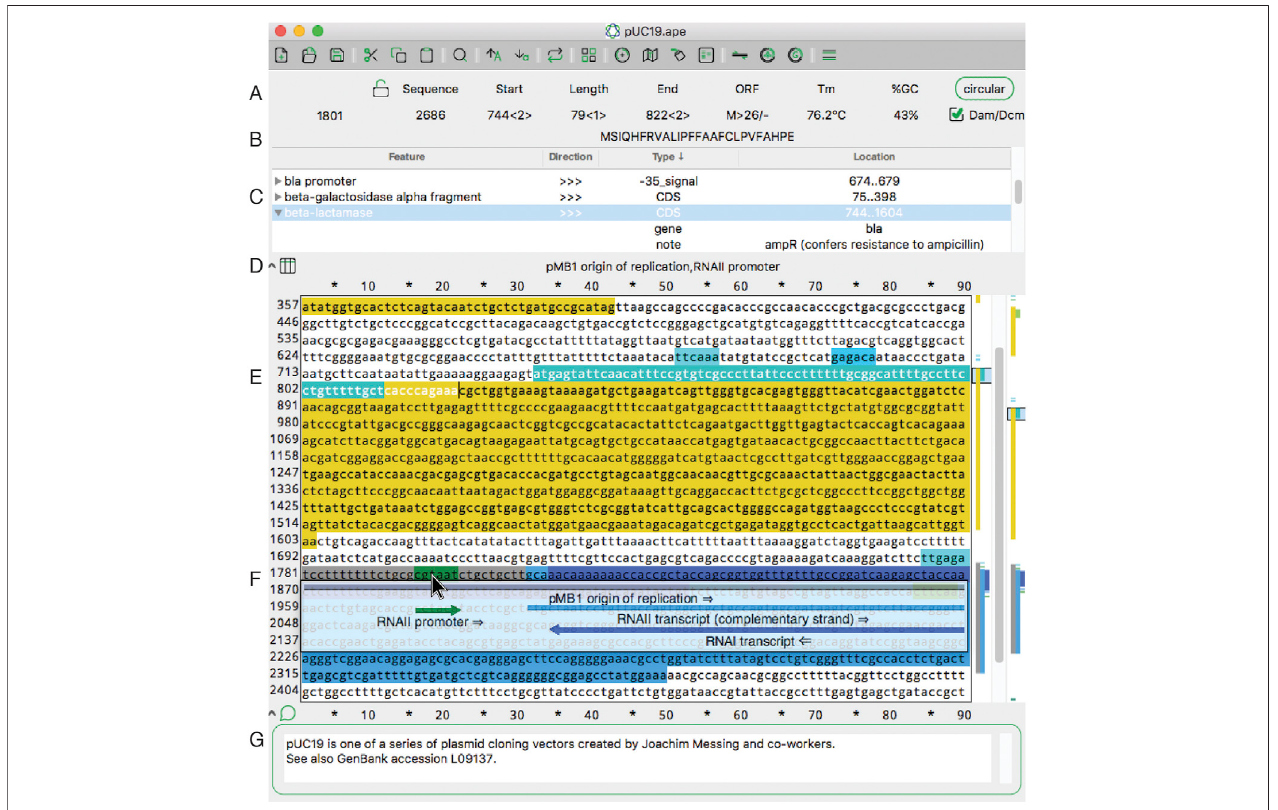
FIGURE1| ThemainsequenceeditingwindowofApE. (A) Thetopsectionofthewindowshowsbasicpropertiesofthesequenceandselectedregion. (B) Thetop section also shows the translation of the selected region. (C) The next pane shows a table of sequence features. Clicking on the arrowhead expands the description of the feature. (D) The next pane shows a list of all features under the mouse pointer (here, hovering over F). (E) The central region of the window contains the text of the sequence, with features highlighted in color. To the right is a vertical representation of these features in the currently displayed region and the scrollbar. On the far right isarepresentation ofall ofthefeaturesinthesequence. (F) Whenactivated, theX-raywindow shows a fl oating window containingagraphicalrepresentation ofthe line of text under the mouse pointer. (G) The bottom of the window shows an editable sequence